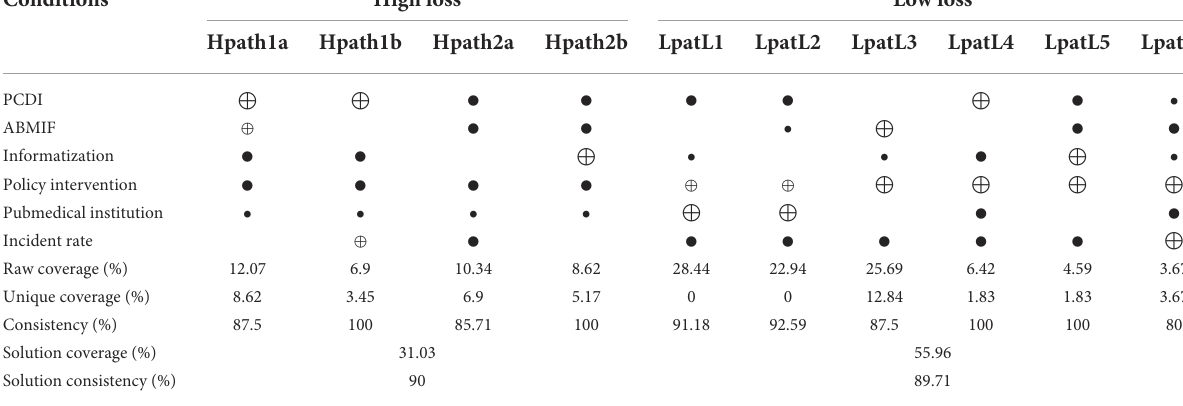
TABLE 4 Core-periphery results of loss caused by medical insurance moral